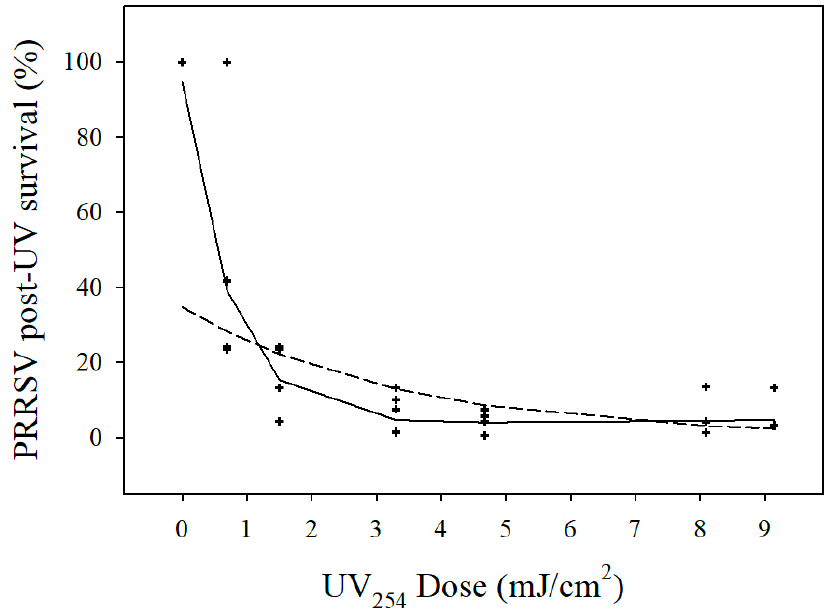
Figure 2. UV-C (254 nm) treatment inactivation of aerosolized PRRSV. PRRSV post-UV survival (%) = N t /N 0 . A log10 normalized PRRSV post-UV survival is shown in Figure A1. One-stage and two-stage inactivation models are marked with dashed and solid lines, respectively.